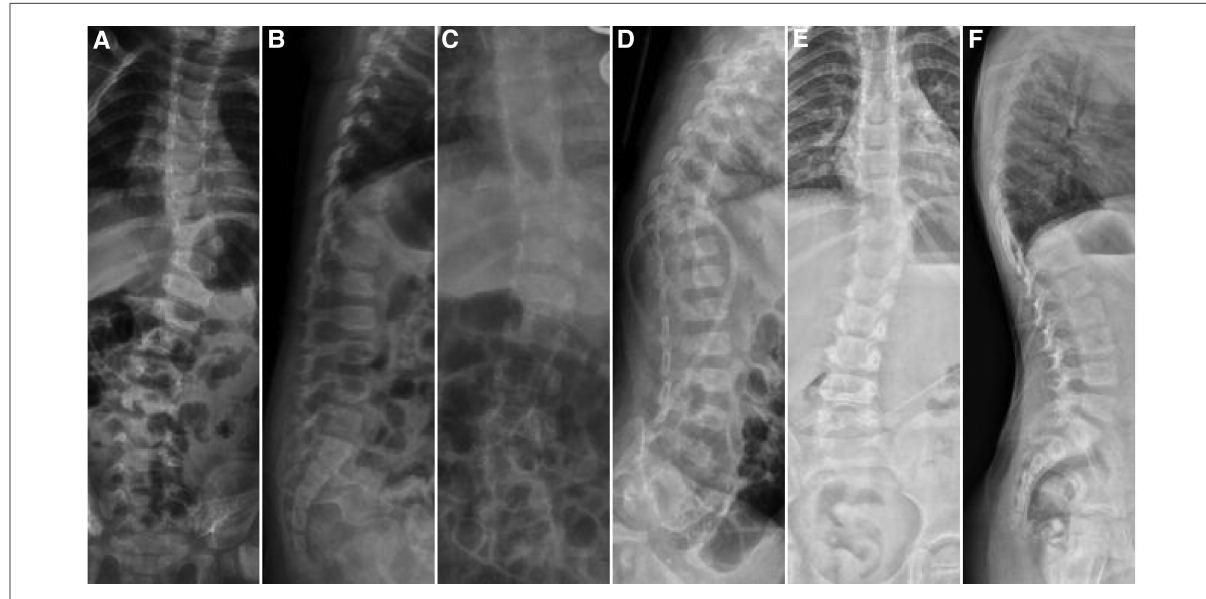
segmented and non-integrated hemivertebrae, and thus have growth potential similar to that of normal vertebrae (2, 15), and therefore the scoliosis deformity progressively worsens